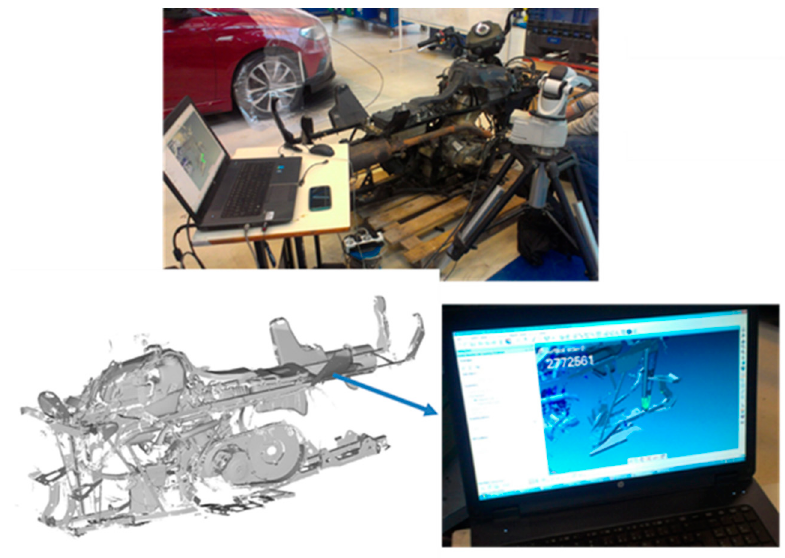
Figure 9. Scanning ICE with Rapidform reverse-engineering software